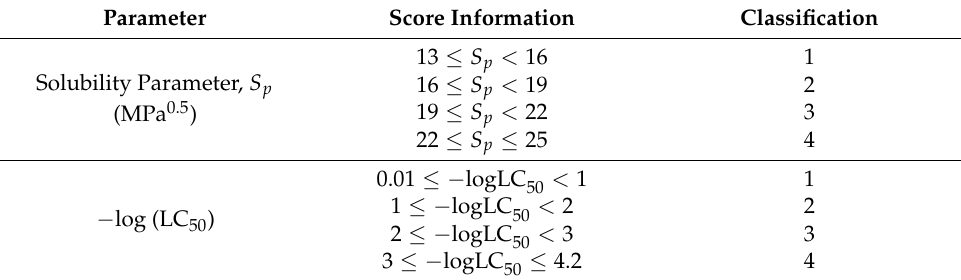
Table 9. Classification for solubility parameter and − log (LC 50 ). Parameter Score Information Classification Solubility Parameter, S